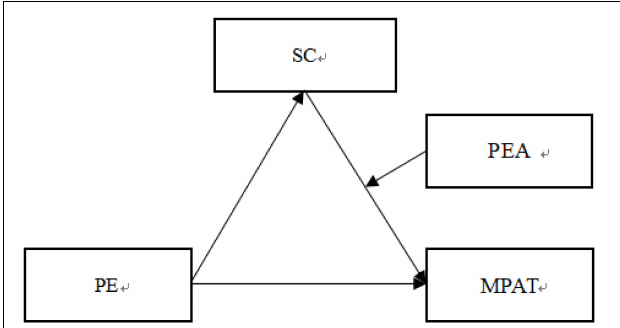
FIGURE 1 | The proposed moderated mediation